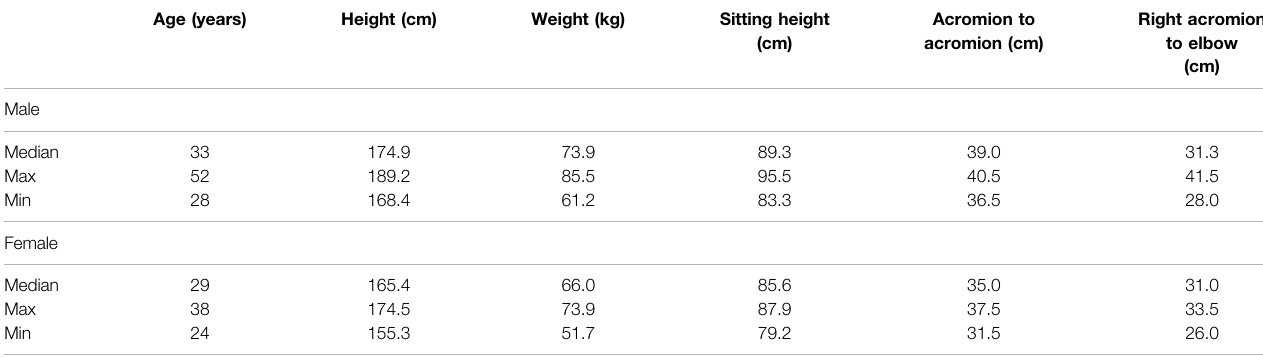
TABLE 1 | Anthropometric measurements of the participants in the present study. The median, maximum, and minimum measurements are shown for both males and females.Sittingheightwasmeasuredfromtheseatbasetothetopoftheheadparalleltotheseatback(17 ° reclinedfromvertical).Thelateralepicondylewasusedforthe acromion to elbow